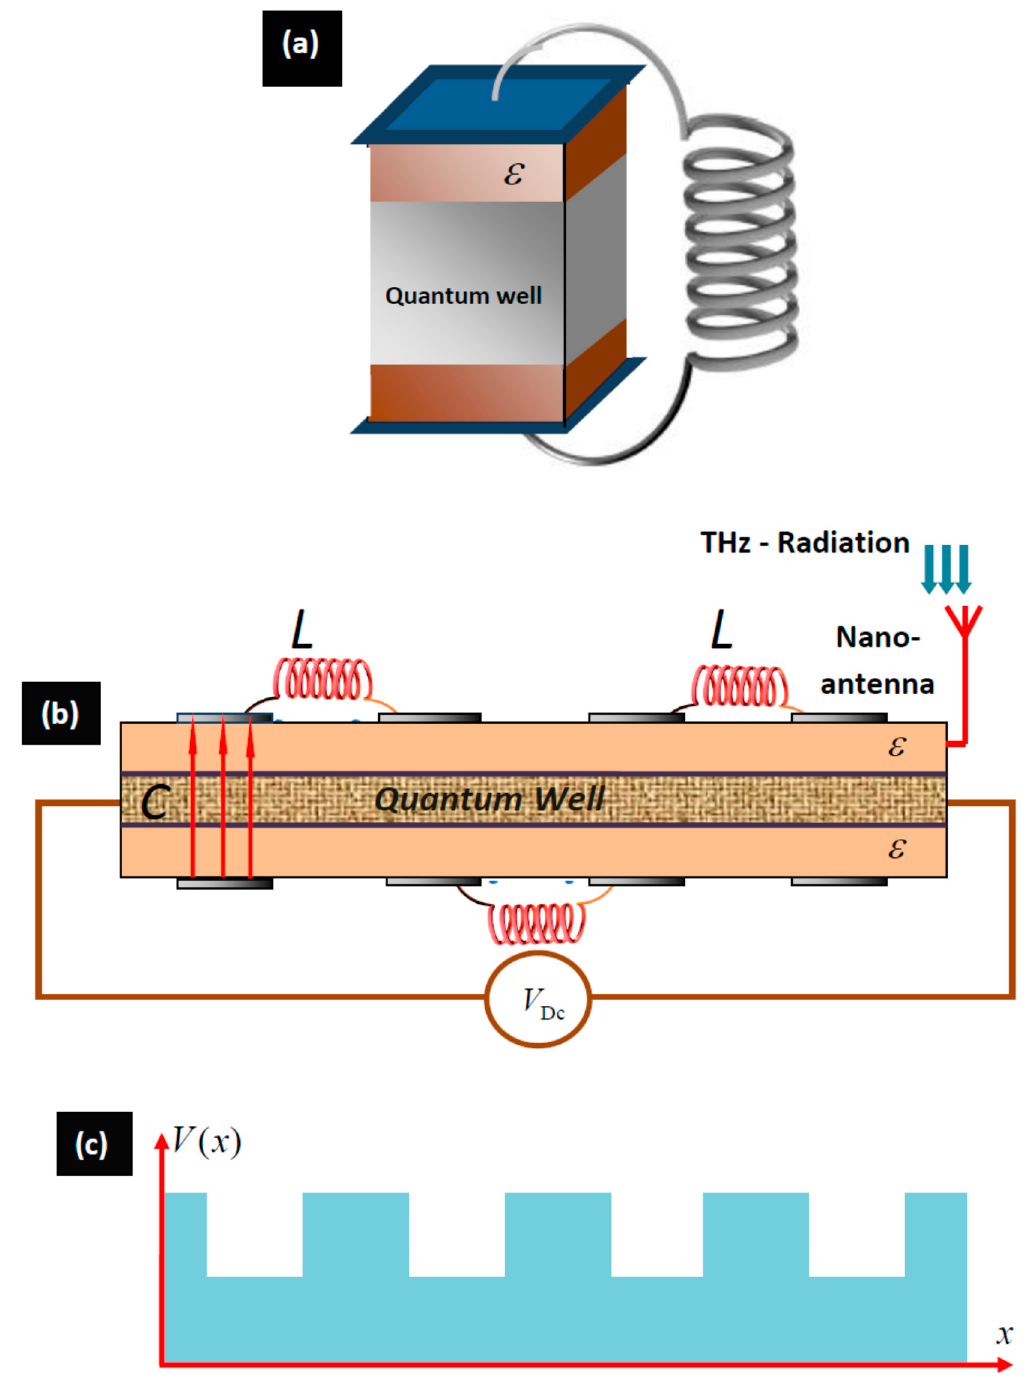
Figure 2. General illustration of the periodic chain used as a model, indicating RBO in ultrastrong coupling regime. ( a ) The single element of the chain. It corresponds to a highly doped quantum well (QW) inserted inside the capacitor of microcavity of THz frequency range [43]. It is resonantly coupled with a mode of microcavity. The frequency matching is reached via the choice of inductance value; ( b ) A highly doped QW inserted inside the capacitors of the chain of coupled microcavities. The dc voltage applied to the system at the ends of the chain. The THz oscillating voltage is applied through a nano-antenna; ( c ) The periodic potential induced by additional doping for transforming the homogeneous QW to the effective superlattice. The coupling is governed by the inter-barrier electron